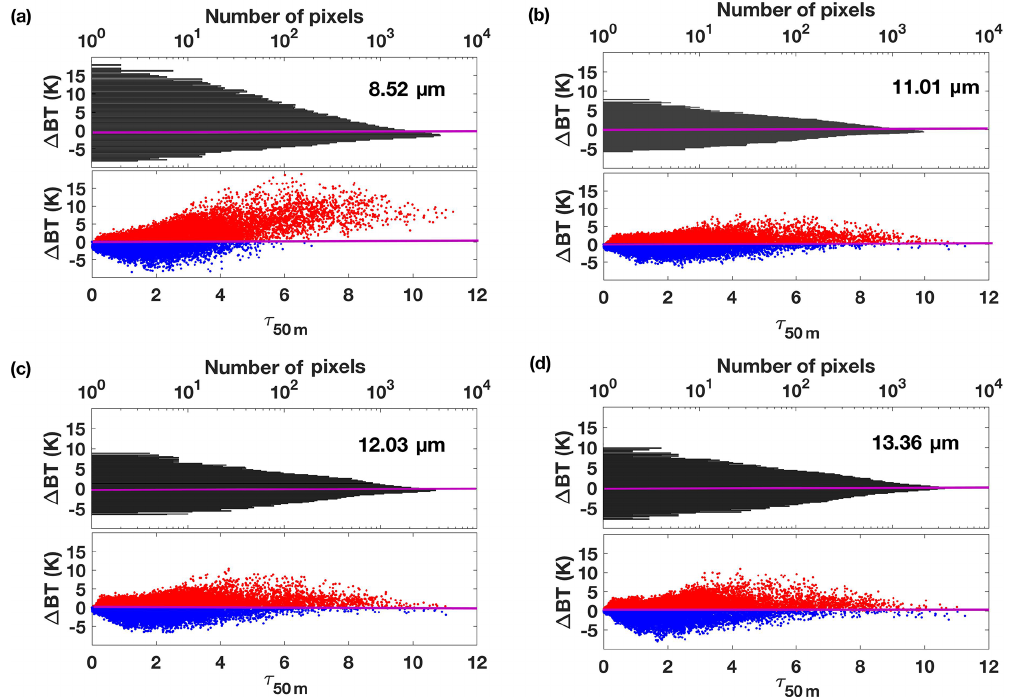
Figure 7. The contribution of the photon horizontal transport to TOA brightness temperature differences between 3-D and 1-D RT at 50m − BT 1-D ( (cid:49) BT = BT 3-D ) seen from nadir as a function of the optical thickness at 12.03m (bottom frame). The fraction of pixel for each 50m 50m (cid:49) BT is shown in the top frame. Positive and negative differences are in red and blue, respectively, at 8 . 52µm (a) , 11 . 01µm (b) , 12 . 03µm (c) and 13 . 36µm (d) . For these four channels, the (cid:49) BT percentage of positive values are 33, 40, 41 and 53%,